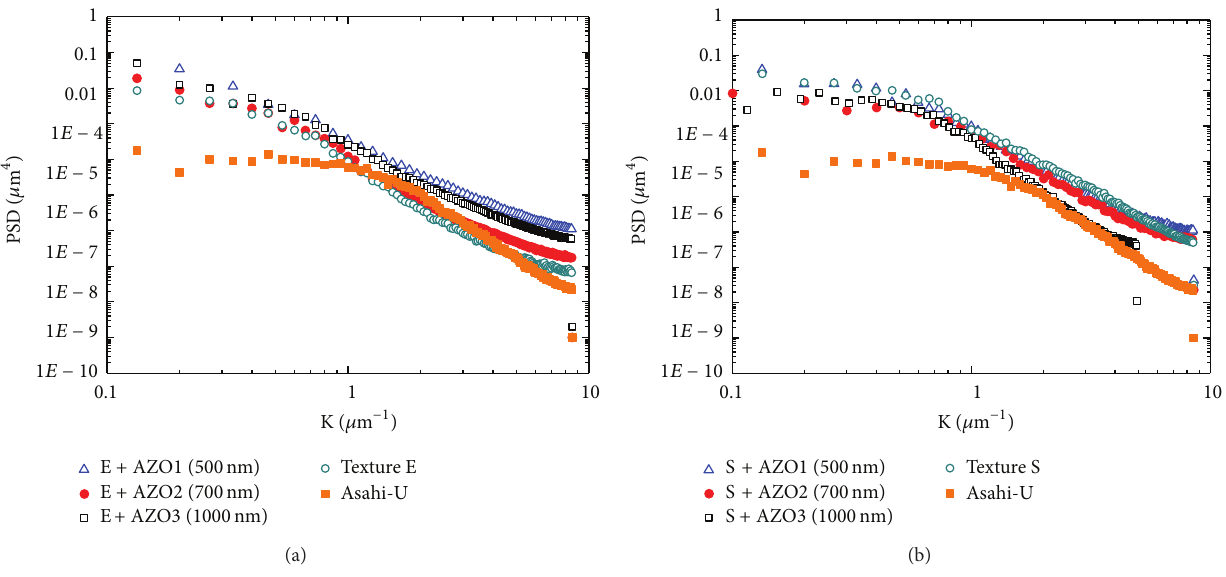
Figure 9: PSD plots for (a) texture E, E + AZO1, E + AZO2, E + AZO3, and Asahi-U and (b) texture S, S + AZO1, S + AZO2, S + AZO3, and